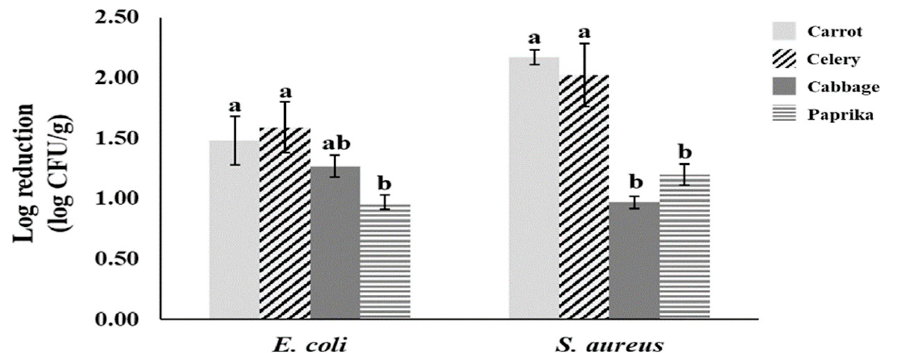
Figure 2. Comparison for reduction effect of combined treatment with SAEW + US + UV-C LED on pathogenic E coli (cocktail of EPEC, ETEC, and E. coli O157:H7) and S. aureus (SEA) in various vegetables. The data were obtained from a non-selective media. a,b Values within each treatment represent different by Duncan’s multiple tests at p < 0.05.